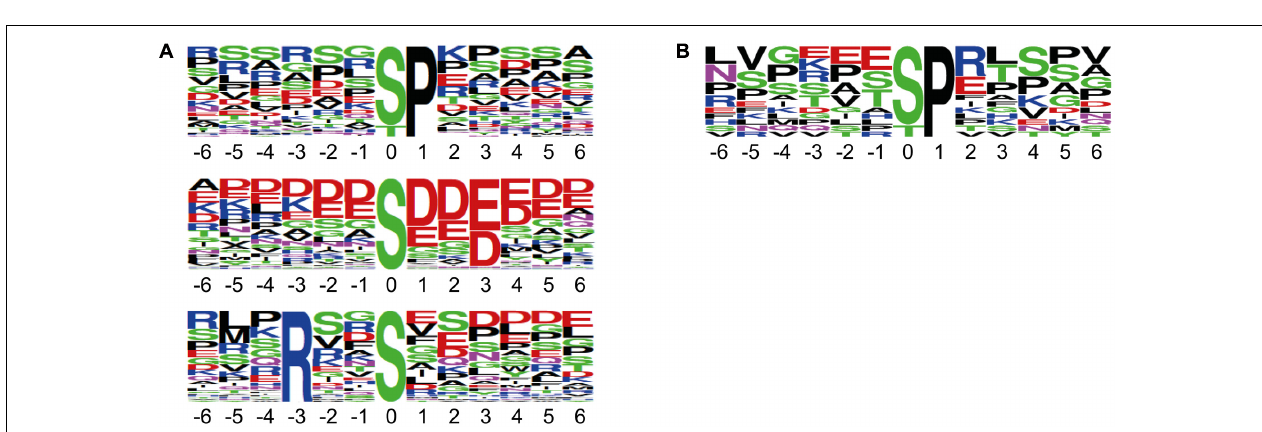
FIGURE 2 | Quantitative analysis of the intensity ratios of labeled and unlabeled peptide pairs. (A) Mass spectra of the phosphopeptide LAAPSpSPFDDDSDDVDEQPLVR mapping to AT4G11740 (SAY1) in tandemMOAC extracted samples of reciprocally 14 N- and 15 N-labeled seedlings treated with ethanol as a control ( − EST) or with β -estradiol ( + EST). m/z represents the ratio of ion mass over the charge of each phosphopeptide ion. (B) Same as in (A) but spectra correspond to the VVLKPVSHpSPK phosphopeptide of AT1G62390 (CLMP1). NL, normalized intensity level (counts per second).